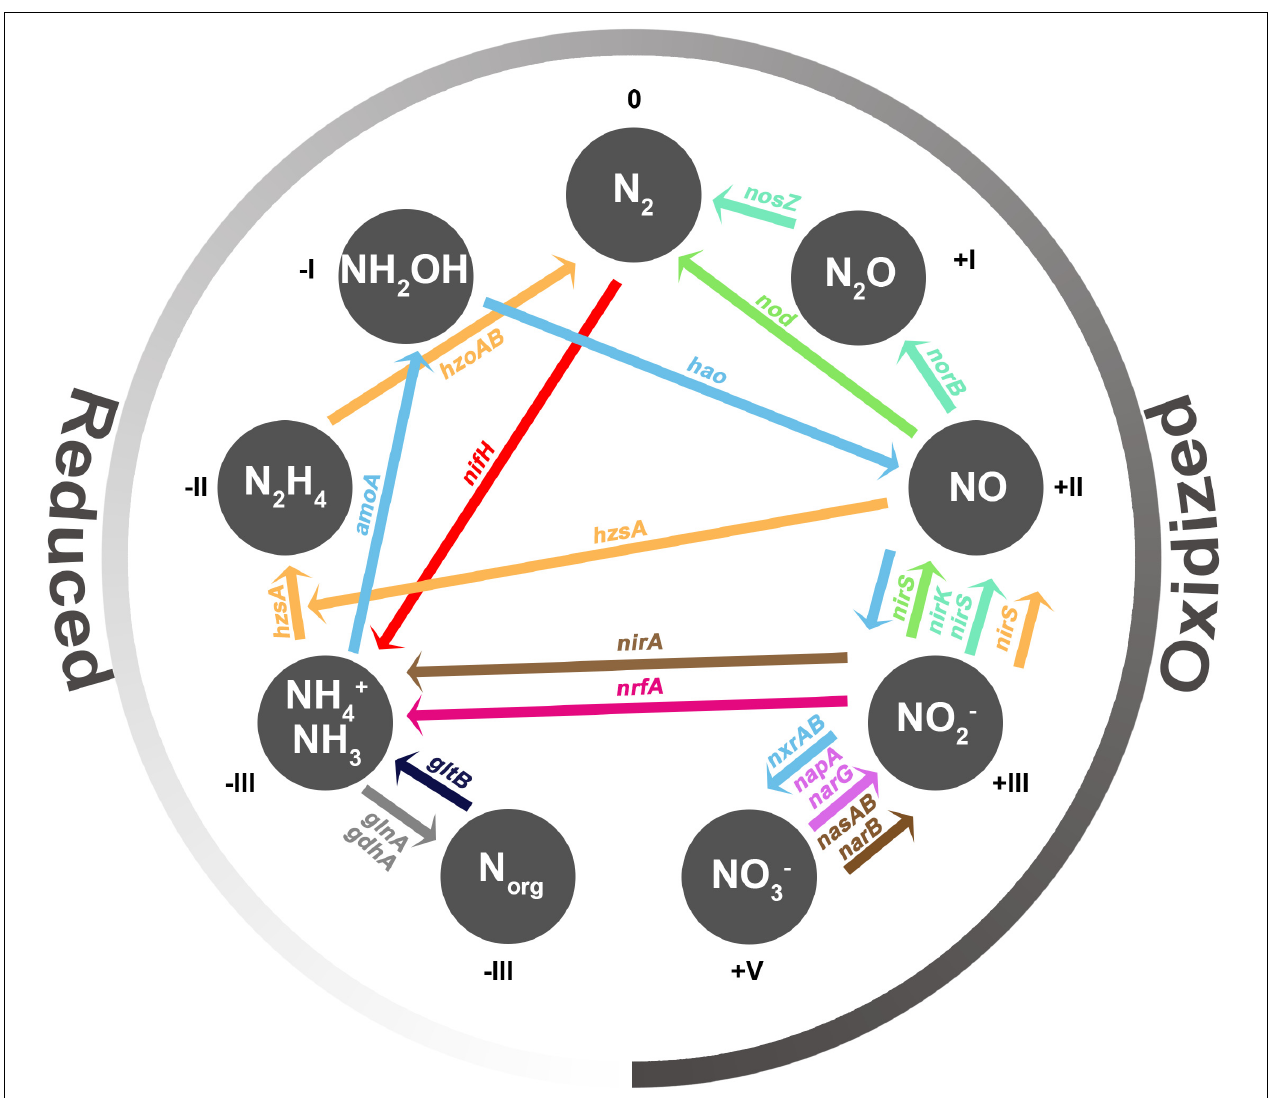
FIGURE 1 | Nitrogen species involved in N cycling and its transformations. Each gray circle represents a N species, and the number next to each N species indicates its oxidation state. Colored arrows represent each N transformation and the main marker genes involved: N 2 fixation ( nifH ) in red, nitrification ( amoA , hao , nxrA , nxrB ) in light blue, nitrate reduction ( narG , napA ) in violet, DNRA ( nrfA ) in magenta, assimilatory nitrate and nitrite reduction to ammonia ( nasA , nasB , narB, nirA ) in brown, ammonium assimilation ( glnA , gdhA ) in gray, remineralization ( gltB ) in dark blue, denitrification ( nirK, nirS, norB, nosZ ) in aquamarine, anammox ( nirS , hzsA , hzoA, hzoB ) in orange, and N-damo ( nirS, nod ) in